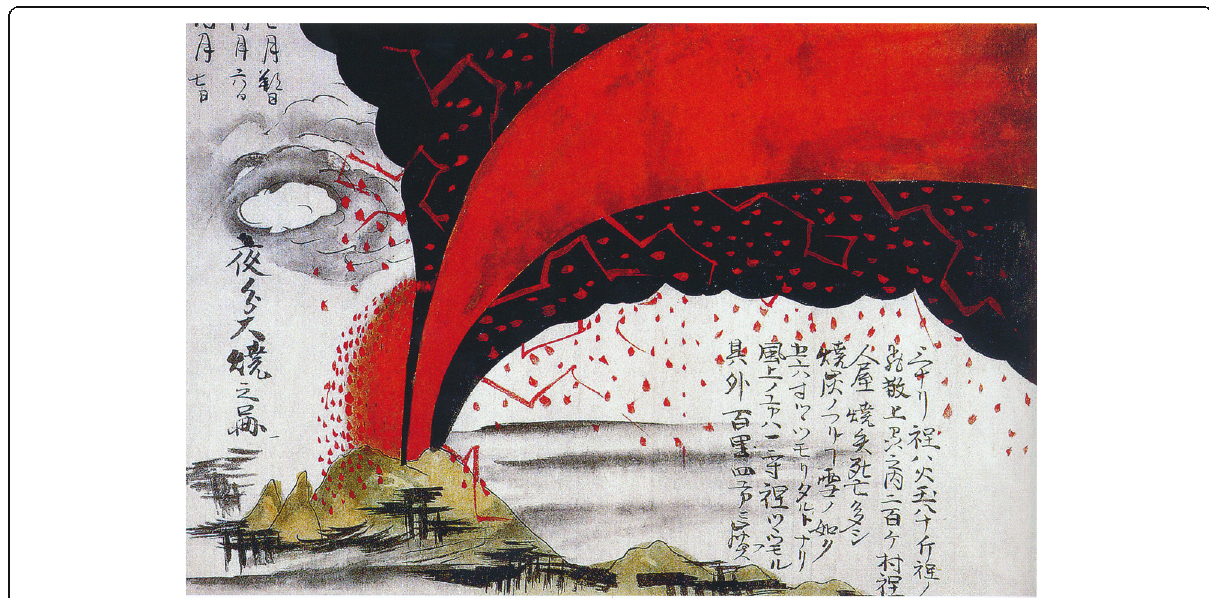
Fig. 15 Historical drawing of the great eruption of Asama volcano in 1783 (Tenmei eruption - NE Japan arc). The annotations give a vivid description of the associated hazards and the scale of the disaster that occurred during this